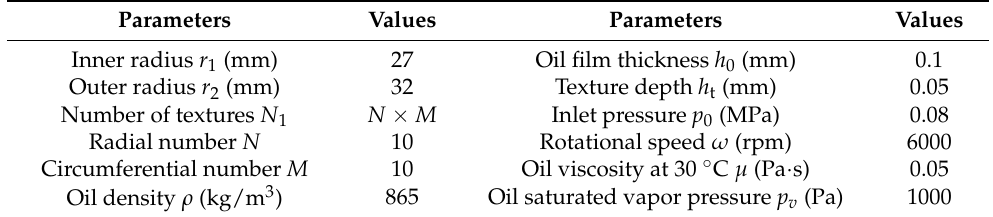
Table 1. Parameters of flow